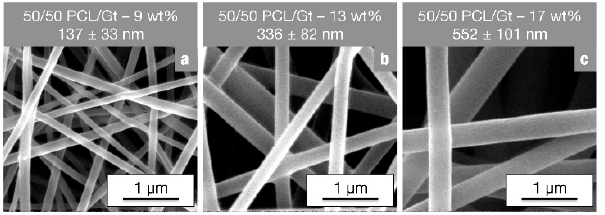
Figure 2. SEM images of 50/50 PCL/Gt blend nanofibers electrospun using 70/30 AA/FA (TCD of 12.5 cm, FR of 1 mL·h − 1 and E adjusted for stable electrospinning) with a total polymer concentration of ( a ) 9 wt%, ( b ) 13 wt% and ( c ) 17 wt%. Varying the total polymer concentration significantly affects fiber diameters.